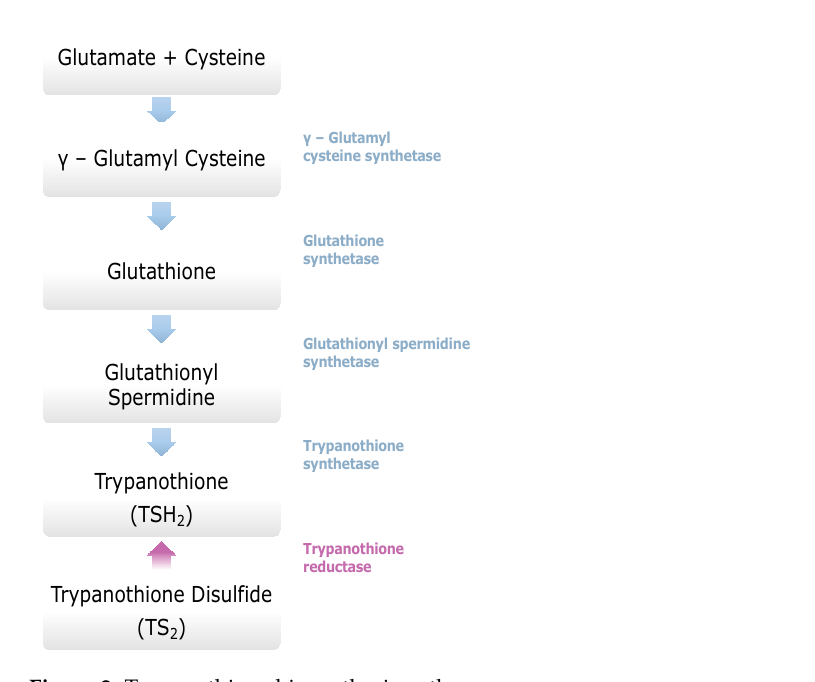
Figure 2. Trypanothione biosynthesis pathway.